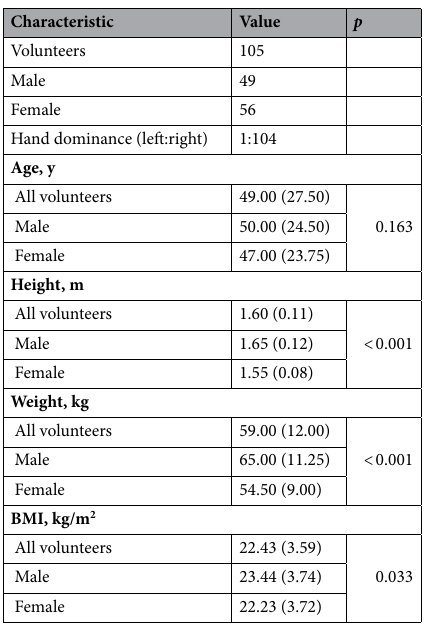
Table 1. The baseline demographic data of the volunteers in this study.